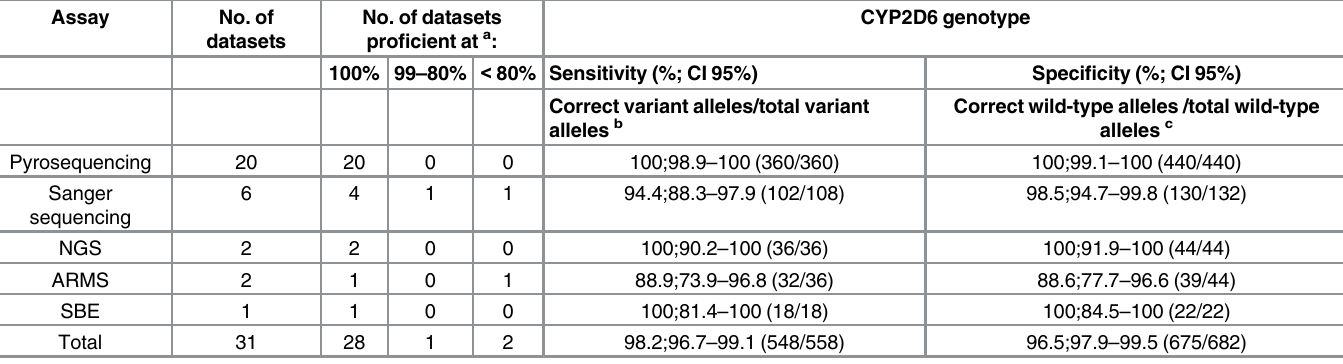
Table 2. Proficiency results and analytical characteristics of genotyping methods used in the study.